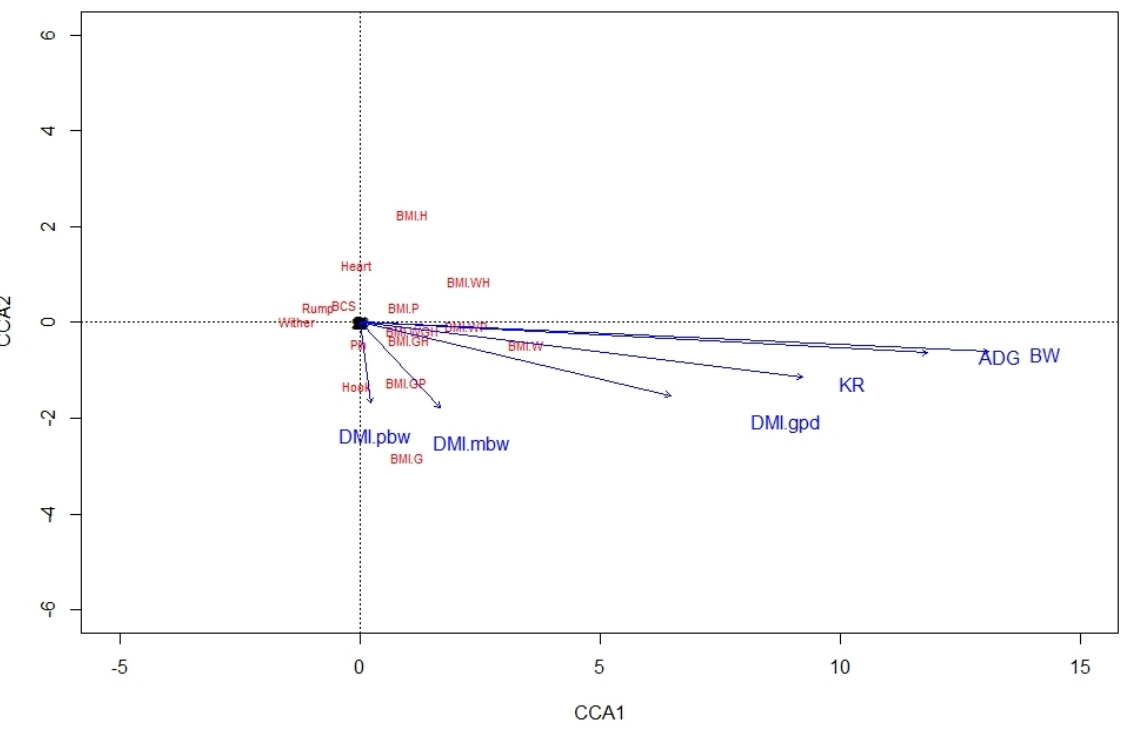
Figure 1. A canonical correspondence analysis (CCA) displaying the relationship between the linear body measures, body condition score, and body mass indexes and performance variables for Alpine doelings. Arrows show the direction of the gradient, with stronger relationships depicted by longer arrows. BCS = body condition score; BW = body weight; ADG = average daily BW gain; DMI.gpd, DMI.pbw and DMI.mbw = dry matter intake in gram per day, percent of BW, and gram per kilogram metabolic BW, respectively; KR = Kleiber ratio (g/kg BW 0.75 ); Wither = height at withers; Hook = point of the shoulder to hook bone; Pin = point of the shoulder to pin bone; Heart = heart girth; Rump = width at hook bones; BMI = body mass index; BMI.W = BW/Wither [g/cm 2 ]; BMI.H = BW/Hook [g/cm 2 ]; BMI.P = BW/Pin [g/cm 2 ]; BMI.G = BW/Heart [g/cm 2 ]; BMI.WH = BW/(Wither × Hook) [g/cm 2 ]; BMI.WP = BW/(Wither × Pin) [g/cm 2 ]; BMI.GH = BW/(Heart × Hook) [g/cm 2 ]; BMI.GP = BW/(Heart × Pin) [g/cm 2 ]; BMI.WGH = BW/(Wither × Heart × Hook) [g/cm 3 ].